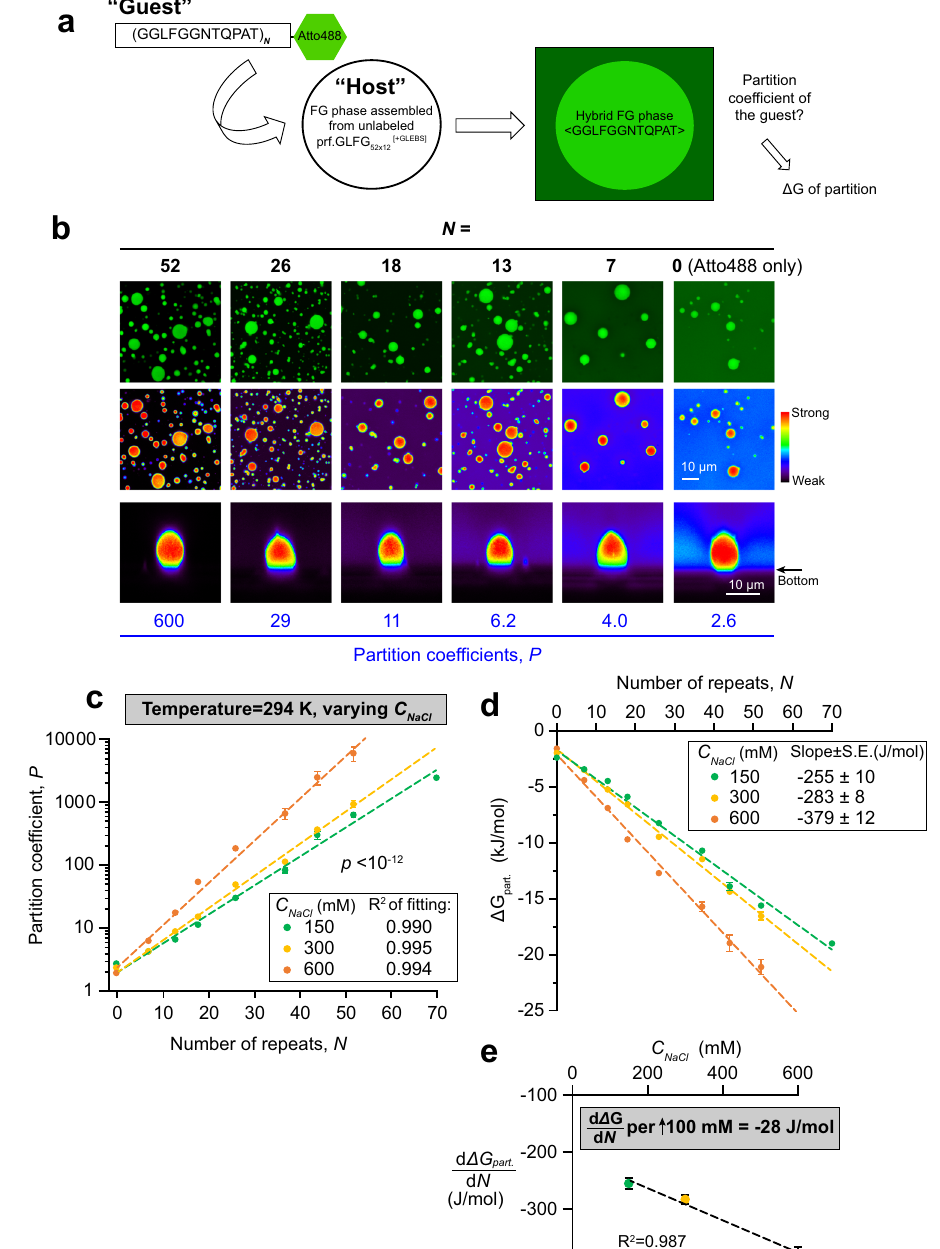
Fig. 1 | Energy contribution per FG repeat unit in FG-FG partition. a Scheme of the partitionexperiments:variants withdifferent number( N )of connected perfect repeat units (as “ guests ” ) were covalently coupled with a chemical fl uorophore (Atto488), and the partition coef fi cient, P of each into a given “ host ” FG phase, formed by prf.GLFG 52×12 [+GLEBS] , was measured by confocal laser scanning micro- scopy (CLSM) at 294K. P is related to Gibbs free energy of partition ( Δ G part .) as describedbyEq.1. b RepresentativeimagesfromCLSM,showingtheAtto488signal of guests with indicated N at 150mM NaCl. Upper two panels: XY scans with green and false colour, respectively. Lower panel: XZ scans with false colour showing an FGparticleineachcondition.Molarratioofhost:guestandscanningsettingsinthe measurements were adjusted individually to cover wide dynamic ranges. For comparison herein, brightness of the FG phase in the images was normalized. the perfect repeats are still interrupted by the GLEBS domain, because this variant has lower saturation concentration of 0.3 μ M 29 than prf.GLFG 52×12 (Supp. Fig. 1), which minimizes interferences of the measurements by host molecules in the aqueous phase. free energy increments ( Δ G repeat ) to the partitioning (see Supp. Table 1